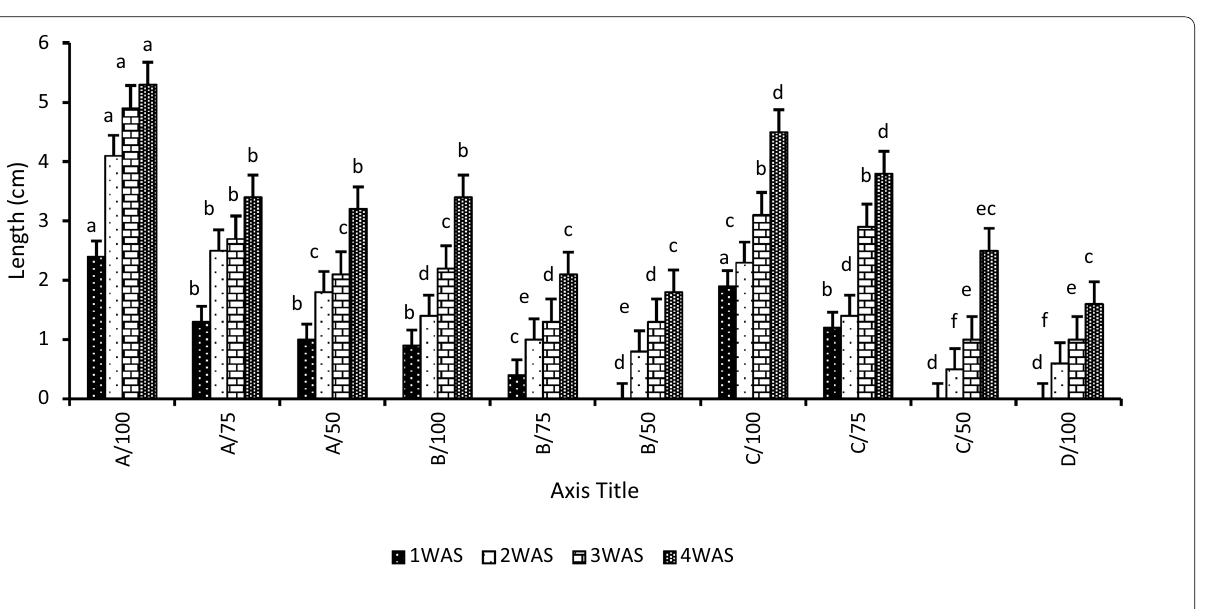
DAS Days after sowing, WAS Weeks after sowing. Results with similar alphabetic superscripts on same column did not differ from each other (p>0.05). A10, A7.5 = = and A5.0 10 ml, 7.5 ml and 5.0 ml of Bacillus sp., respectively. B10, B7.5 and B5.0 = ml and 5.0 ml of Klebsiella sp ., respectively. D10 10 ml of control. =